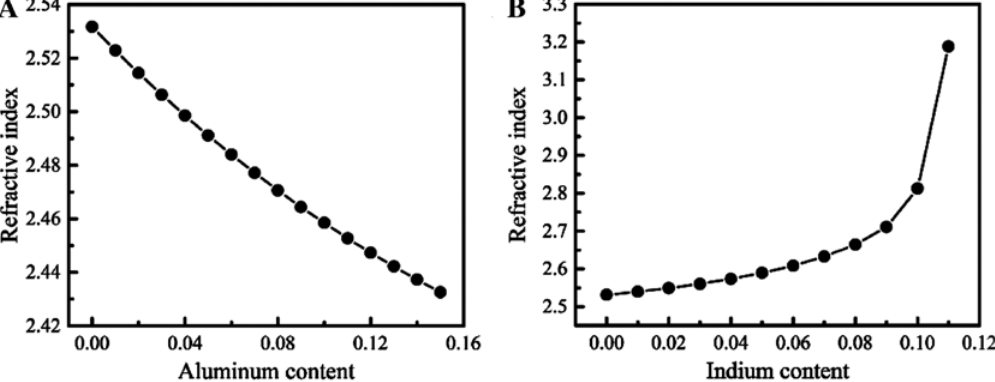
Figure 3: The refractive indexes of AlGaN decrease along with the aluminum increasing, and the refractive indexes of InGaN alloys increase along with the indium